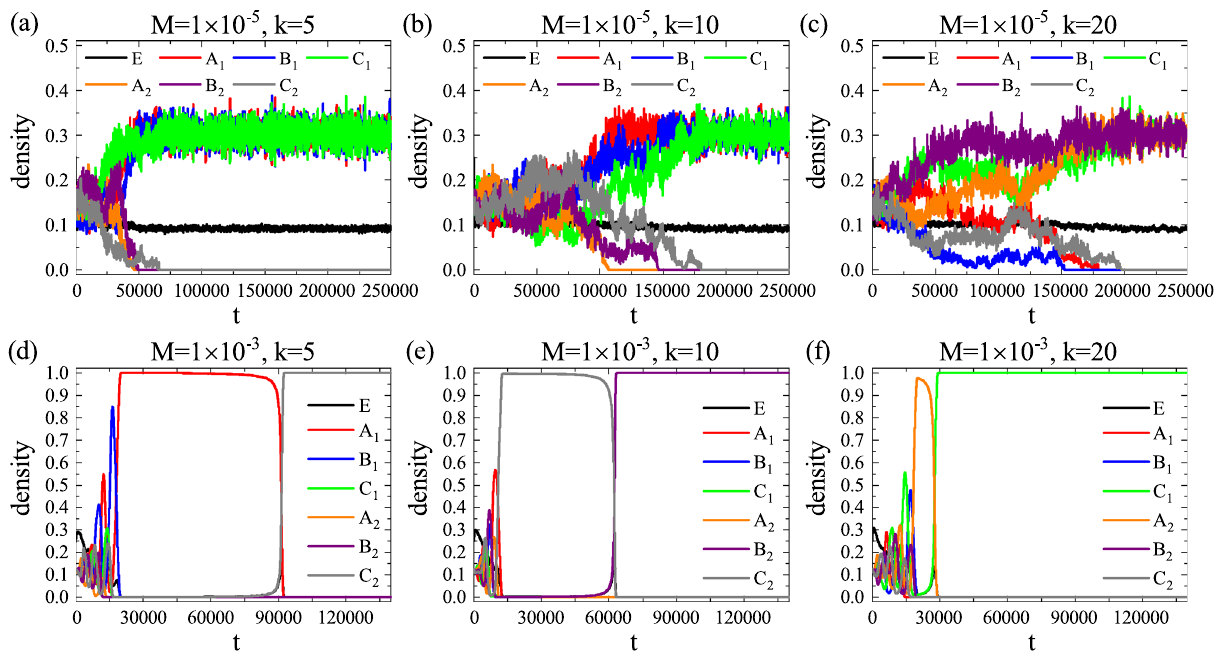
Figure 2. Time dependent evolution of densities in the system for different M and k . Top and bottom panels are obtained with M = 1 × 10 − 5 and M = 1 × 10 − 3 , respectively, and the sensitivity parameter k is given by k = 5 , 10, and 20 from the left to right in each row. ( a – c ) Regardless of the choice k , the low mobility still leads species coexistence as usual. ( d – f ) At high mobility regimes, the system also always exhibit the extinction